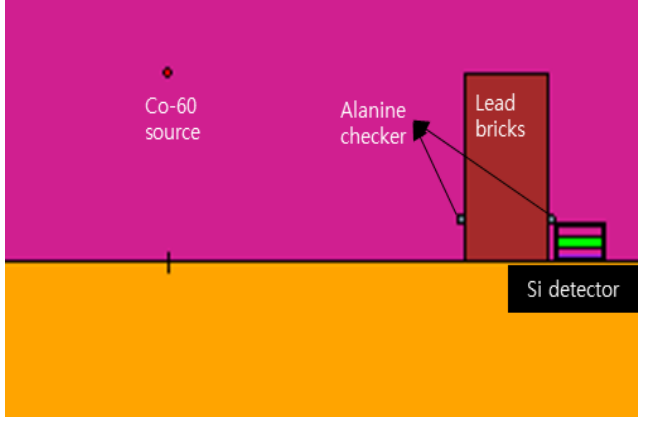
Fig. 5. MCNP geometry to calculate the experimental absorbed dose on the silicon sensor and premplifier